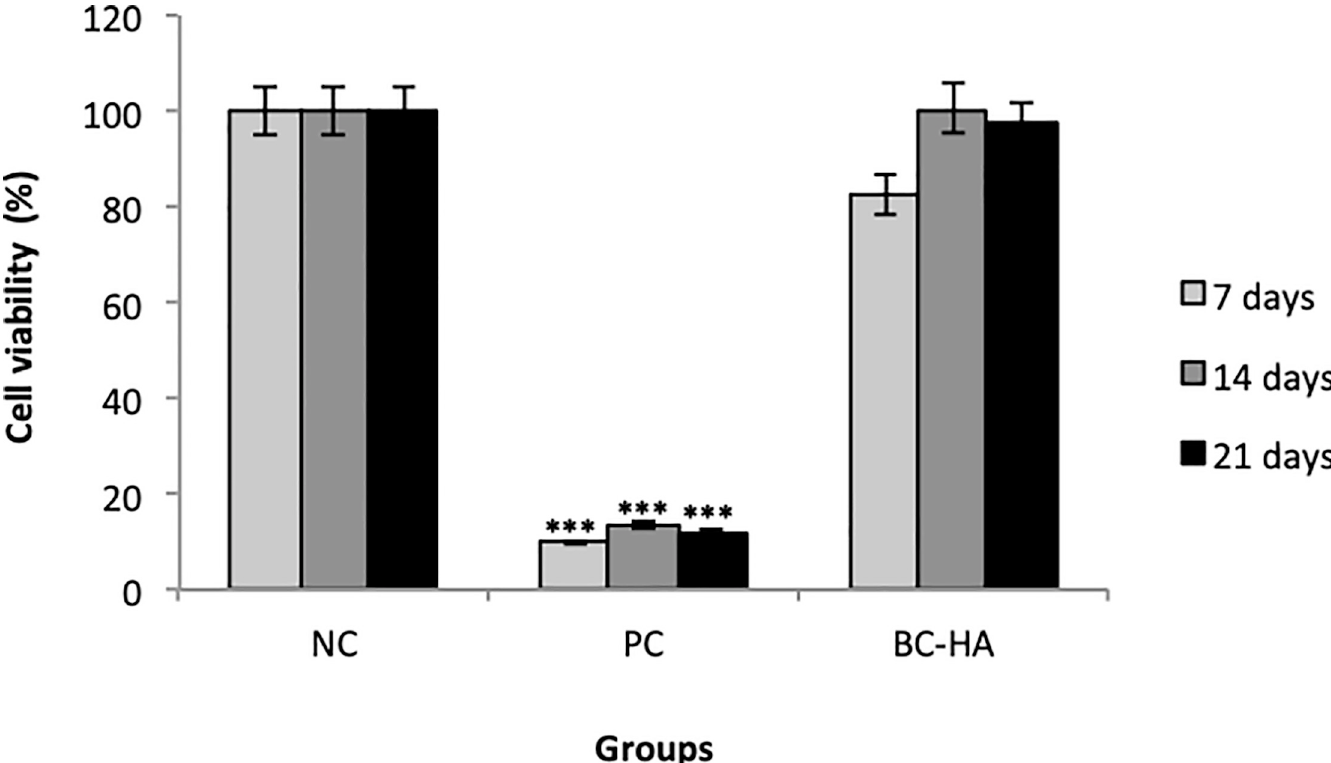
Fig 3. Cytotoxicity (cell viability) assessed by the XTT method. Columns indicate mean cell viability values. Bars indicate standard errors. The ��� symbol indicates a statistically significant difference compared to NC (p < 0.0001). Dunnett’s test.